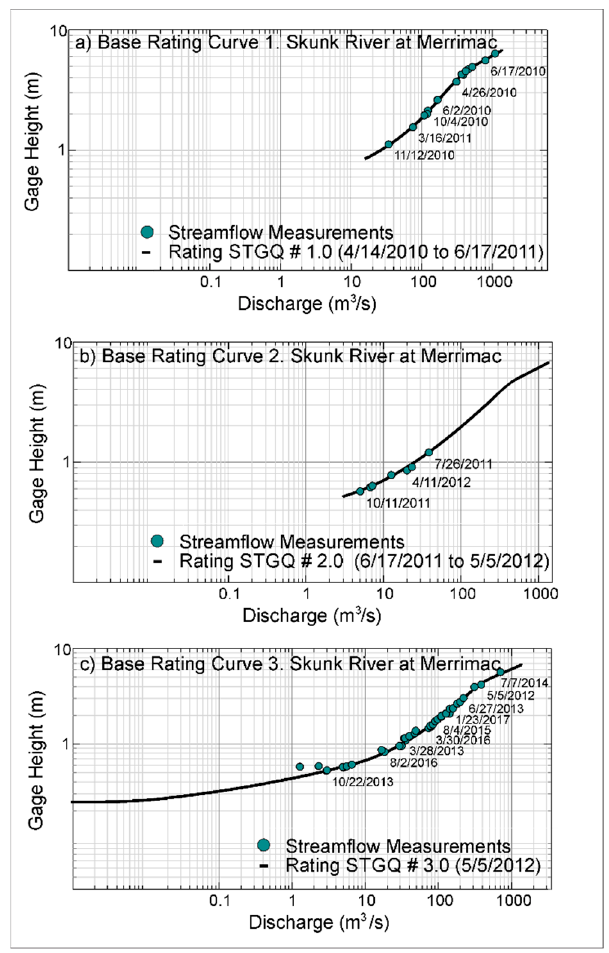
Figure 4. Base rating curves for Skunk River at Merrimac. Cyan dots represent streamflow measurements and black line represents the base rating curve for the period ( a ) 14 April 2010 to 17 June 2011; ( b ) 17 June 2011to 5 May 2012; ( c ) 5 May 2012 through the end of the study period.